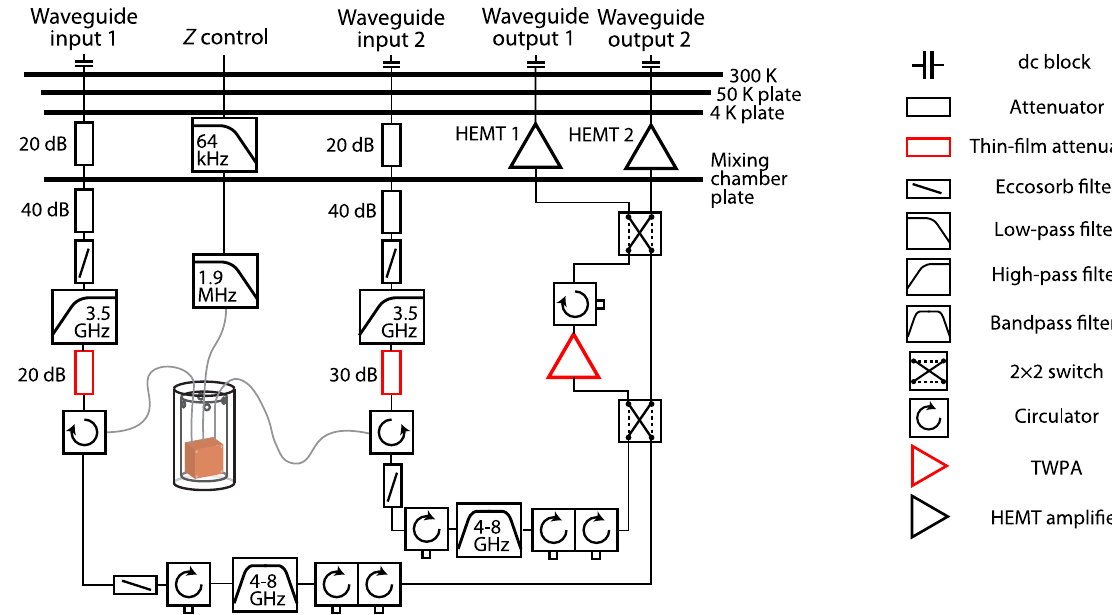
FIG. 10. Schematic of the measurement setup inside the dilution refrigerator for device I. The meaning of each symbol in the schematic on the left is enumerated on the right. The level of attenuation of each attenuator is indicated with number next to the symbol. The cutoff frequencies of each filter are specified with numbers inside the symbol. Small squares attached to circulator symbols indicate port termination with Z 0 ¼ 50 Ω , allowing us to use the three-port circulator as a two-port isolator. The input pump line for TWPA is not shown in the diagram for